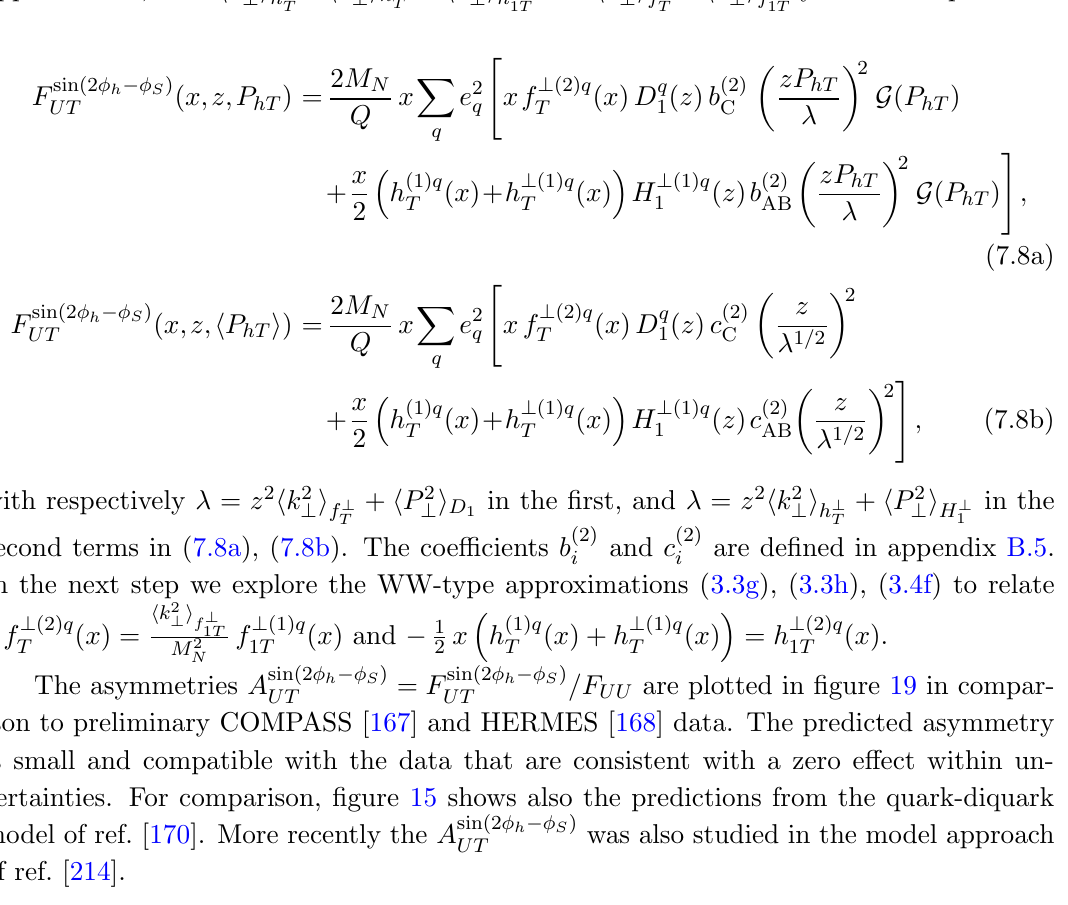
( x ), which is predicted to vanish in the UT